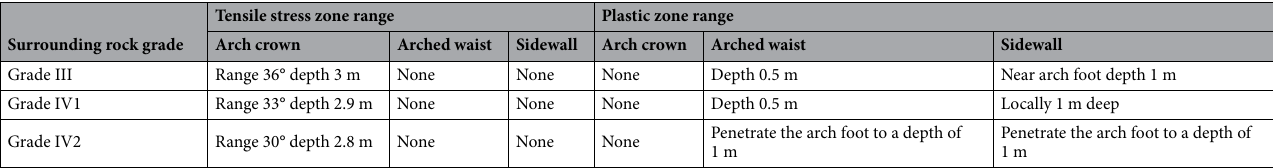
Table 10. Comparison of the tensile stress zone and plastic zone range of the surrounding rock of different grades.